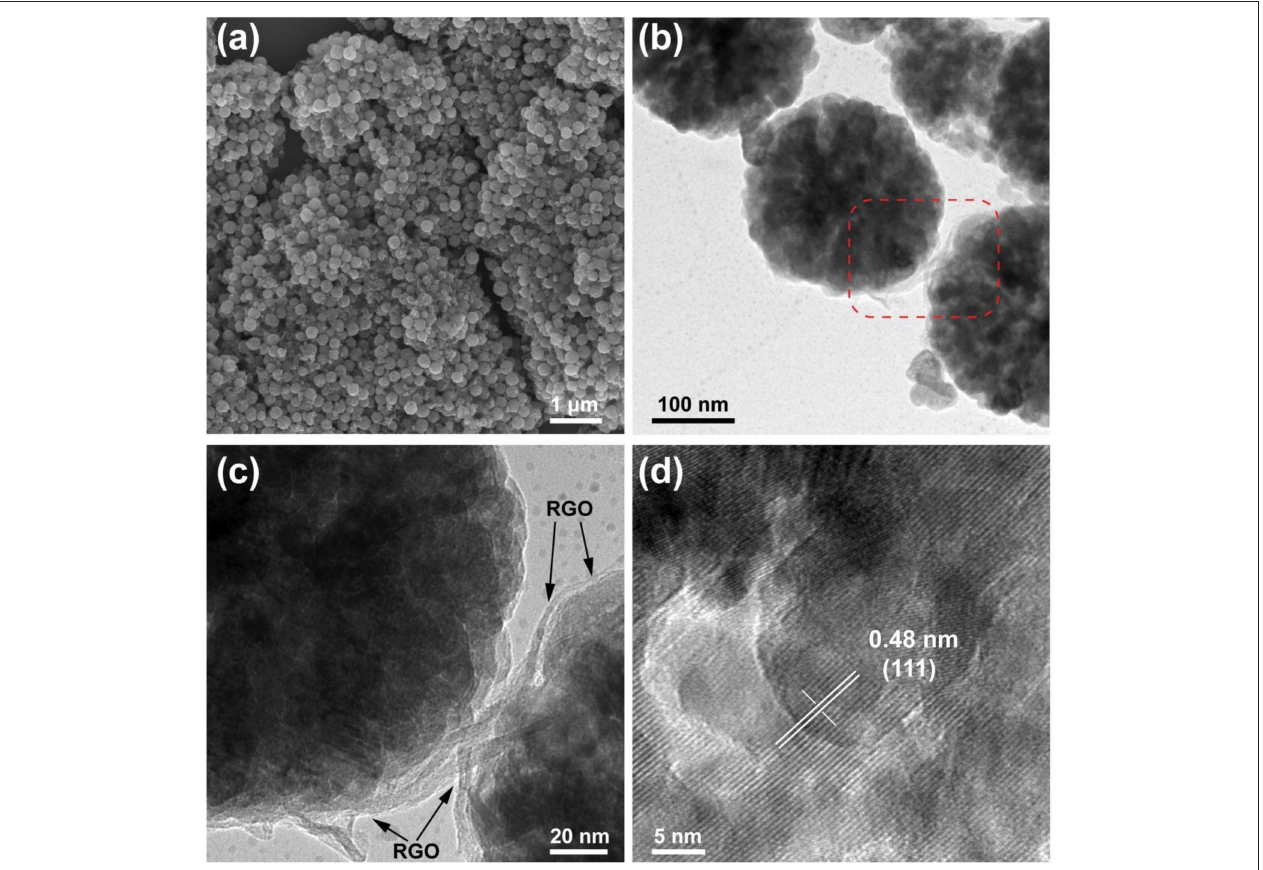
FIGURE 2 | The SEM images of (a) 10wt%-Fe 3 O 4 @RGO,typical TEM images of (b) 10wt%-Fe 3 O 4 @RGO, (c) enlarged view of 10wt%-Fe 3 O 4 @RGO and (d) HRTEM image of 10wt%-Fe 3 O 4 @RGO.